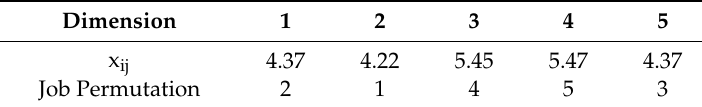
Table 2. Job permutations and the corresponding position information after swapping job2 and job4 for a swap-based local